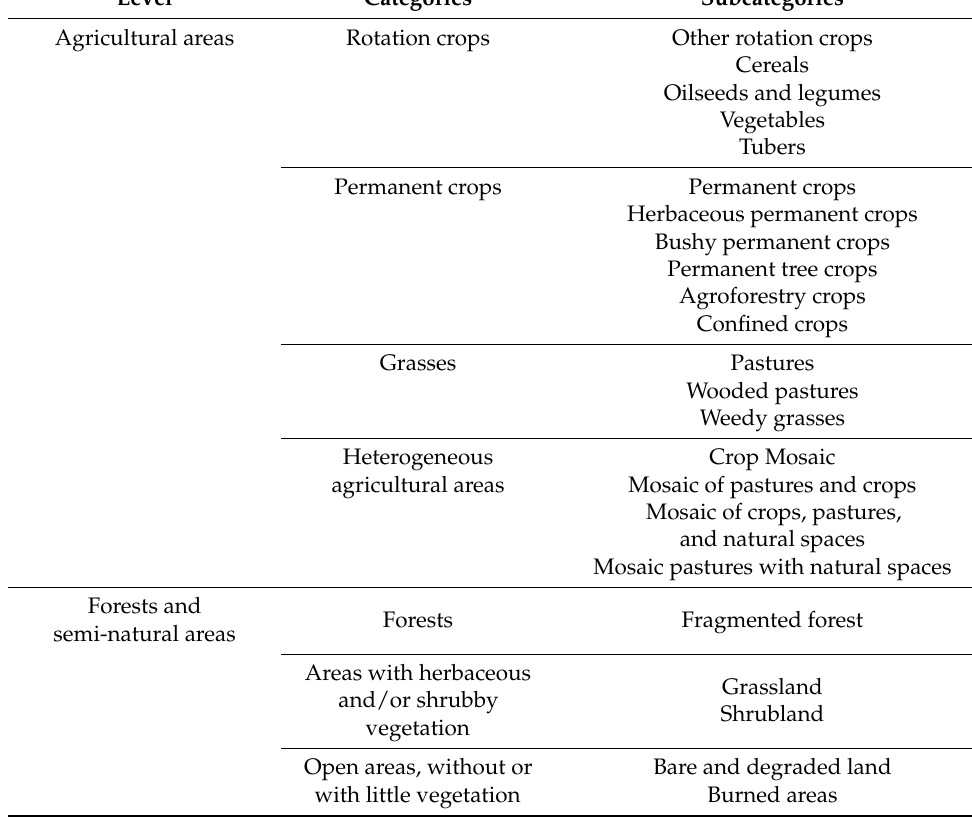
Table 1. Coverage level, category, and subcategory selected according to Corine Land